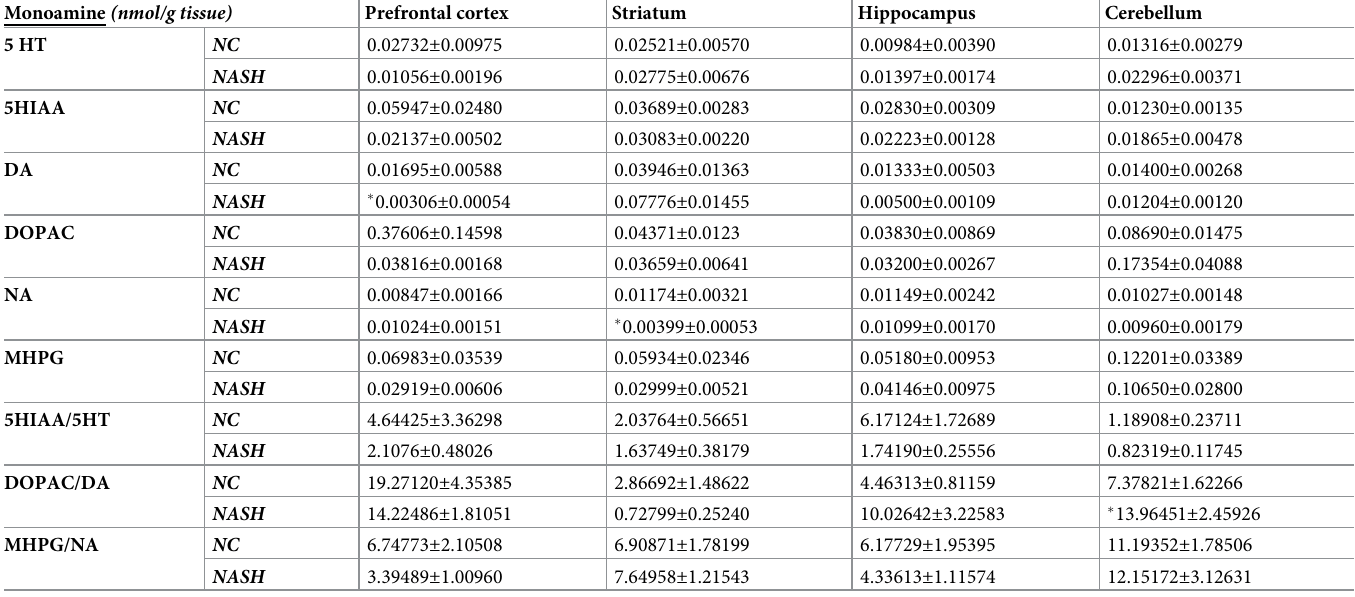
Table 5. Brain contents of monoamine neurotransmitters and their metabolites. Monoamine (nmol/g